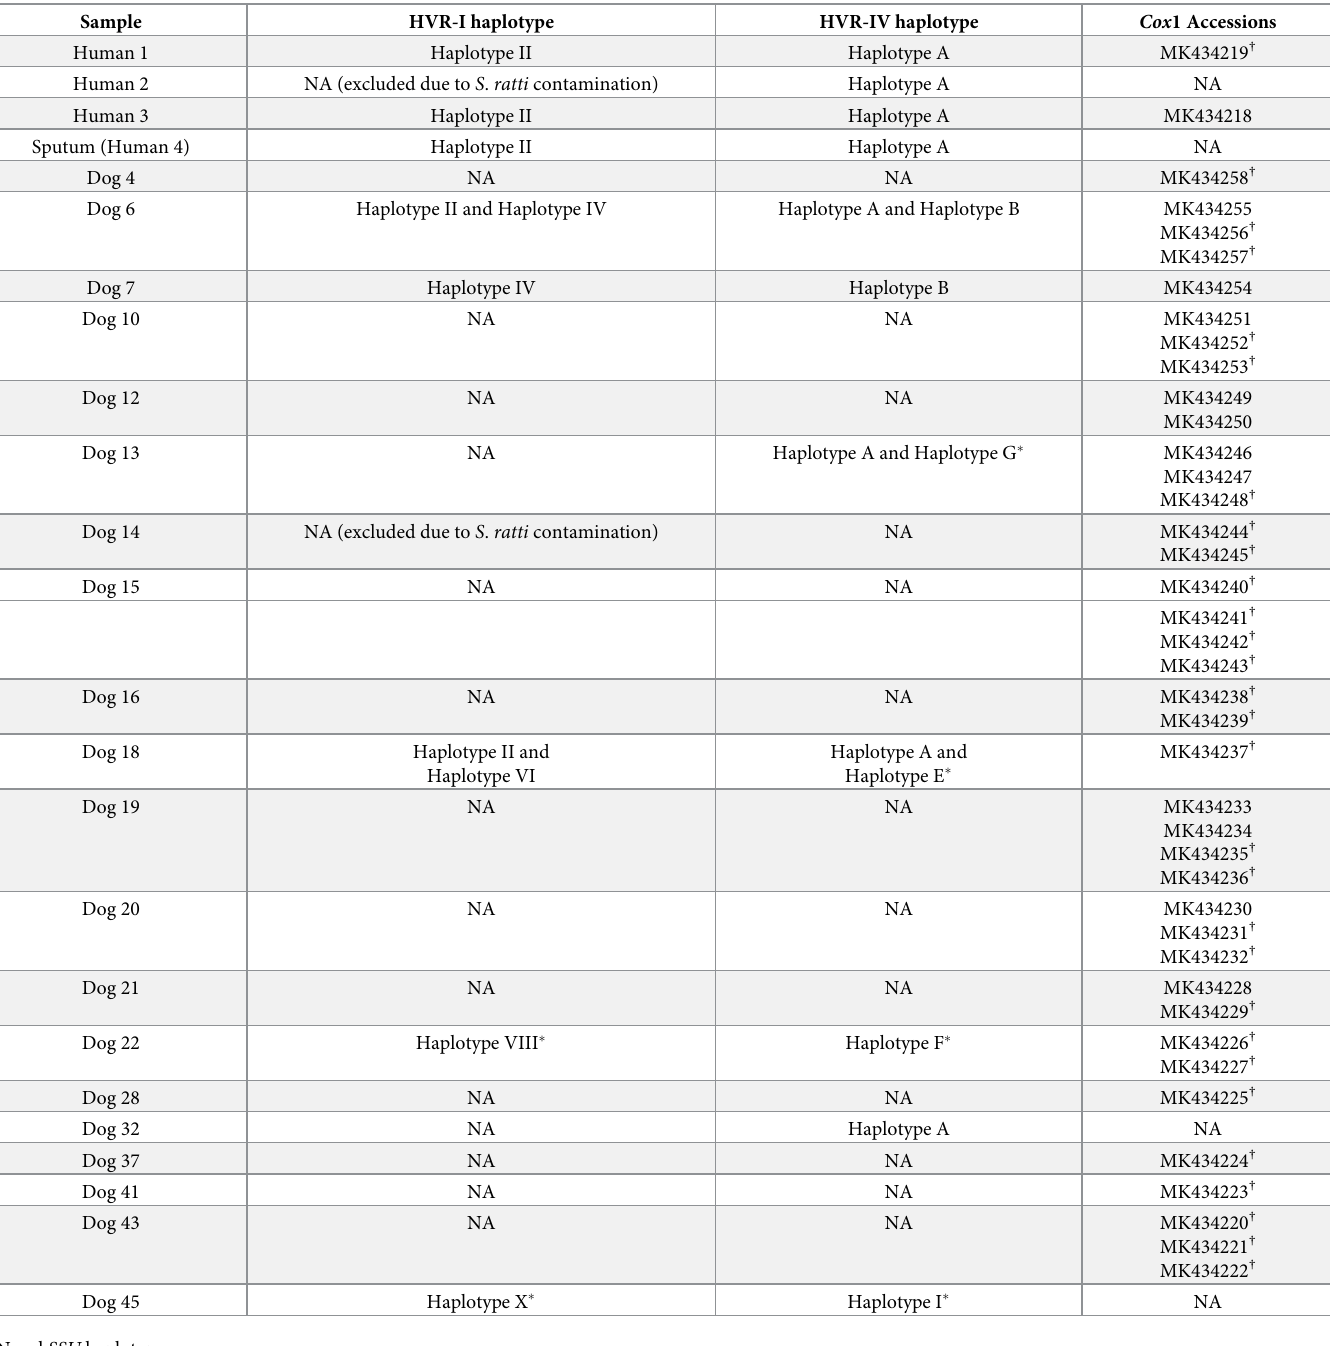
Table 4. Human and dog samples analyzed in this study and their